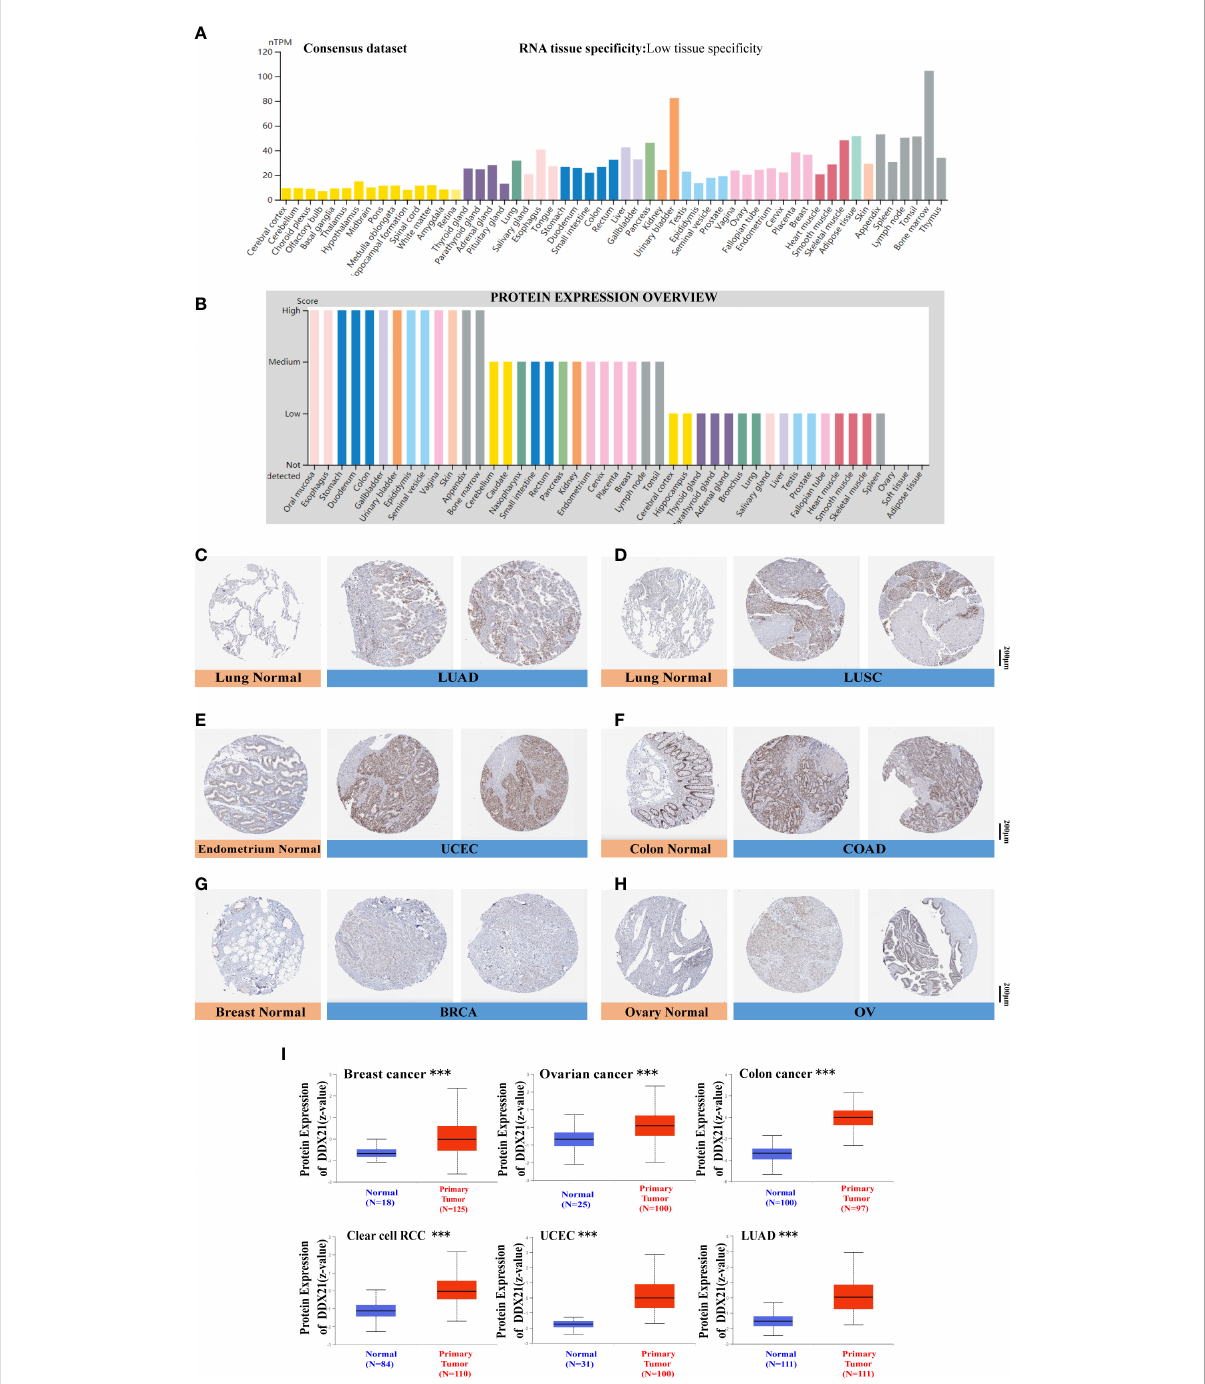
FIGURE 2 DDX21 expression pro fi les in human normal and cancer tissues. (A) Consensus DDX21 tissue expression based on datasets of HPA (Human Protein Atlas), GTEx, and FANTOM5 (Function ANnoTation Of the Mammalian genome). (B) Abundance of the DDX21 protein in human normal tissues. Representative IHC images of DDX21 expression between normal (left) and tumor (right) tissues. (C, D) Lung. (E) Endometrium. (F) Colon. (G) Breast. (H) Ovary. (I) Based on the CPTAC dataset, we also analyzed the abundance of DDX21 protein between normal tissues and primary breast cancer, ovarian cancer, colon cancer, clear cell RCC, UCEC, and LUAD tissues (***p <